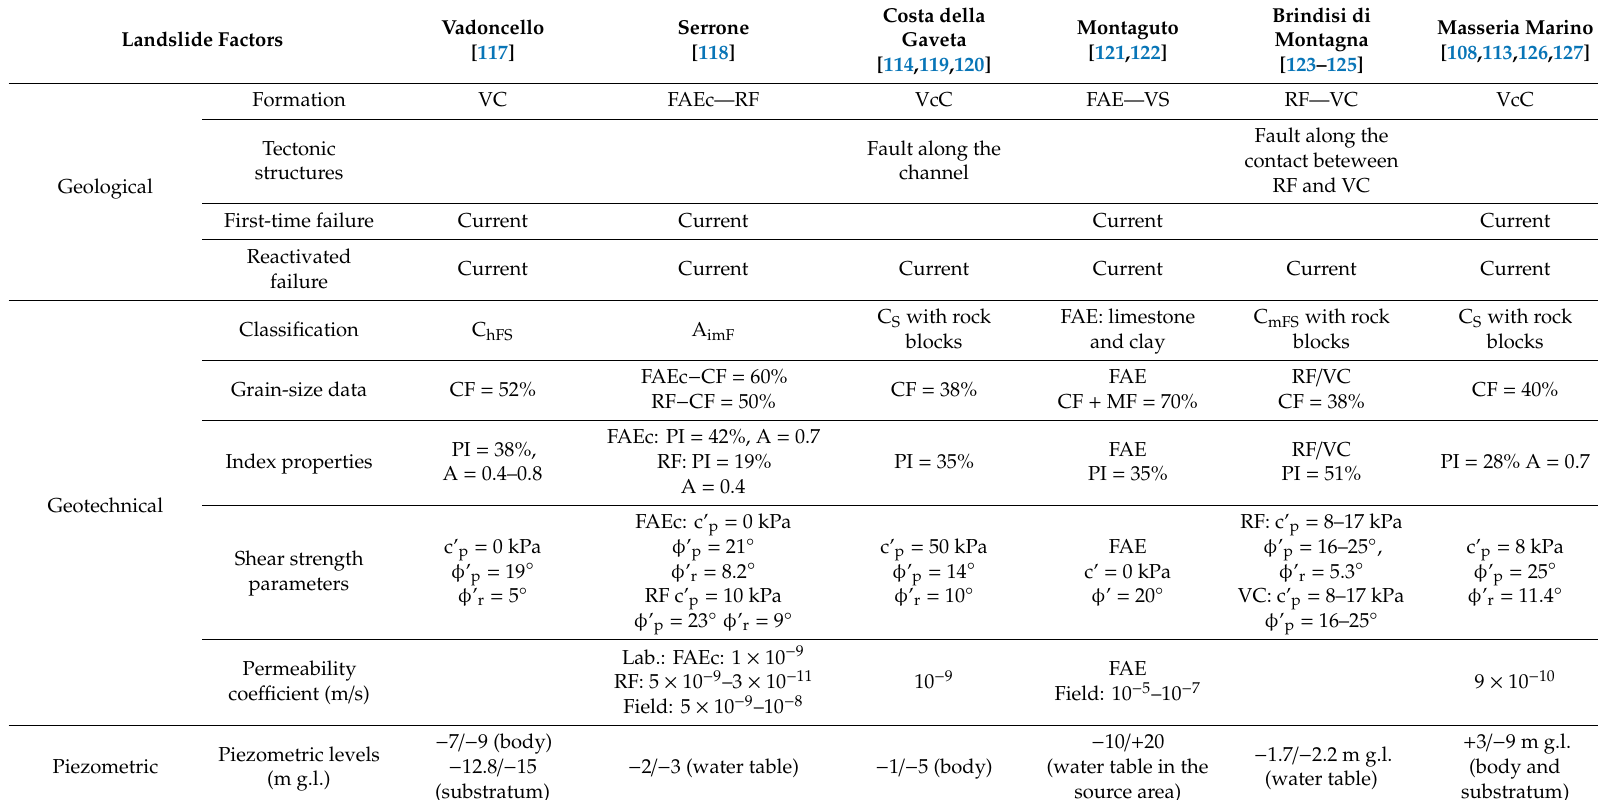
Table 6. Landslide factors of some landslide mechanisms belonging to class 4 (Figure 11; [108,113,114,116–118,122,123,126–129]); for the geotechnical parameters referring to Tables 3 and